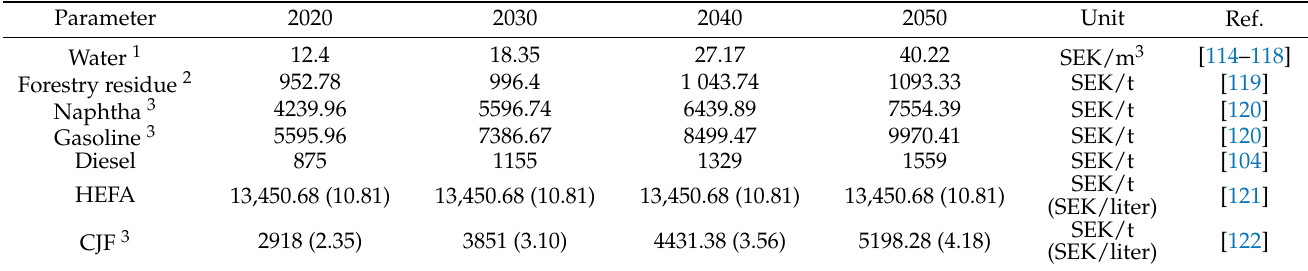
Table 6. Annual utility prices and market prices of HEFA and CJF.